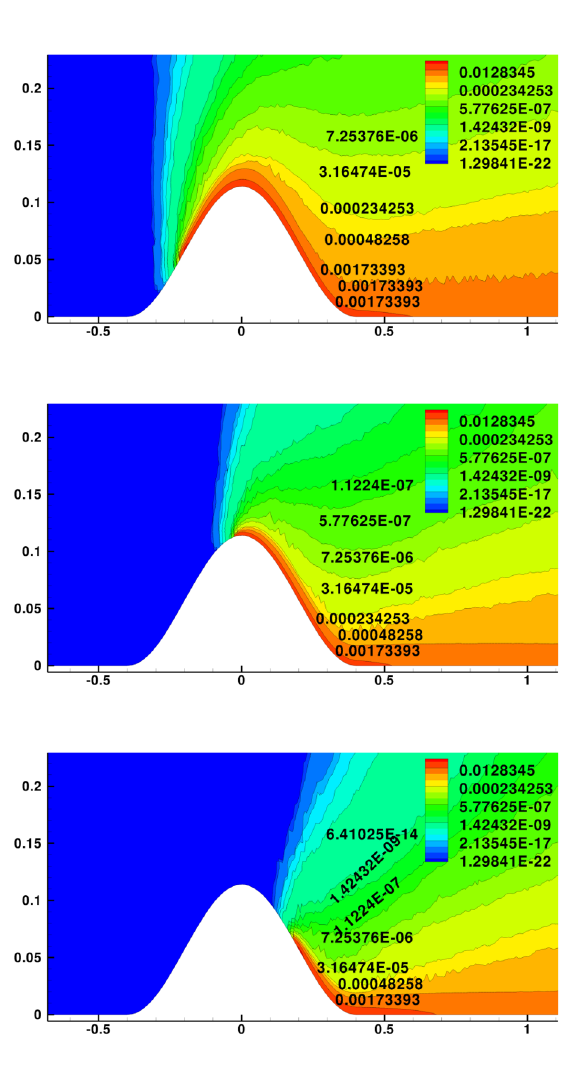
Fig. 4. The flow over the terrain wave: numerical simulation, mass fraction Y 1 of the emmision for various source